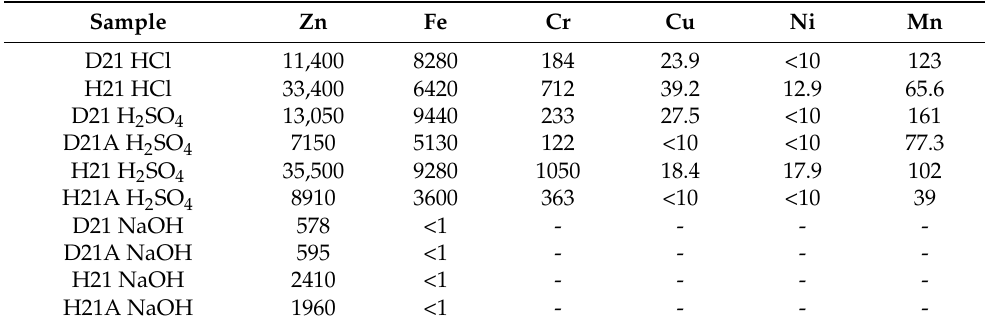
Table 15. The result of AAS analyses of the electrolytes after the electrolysis (mg/L).